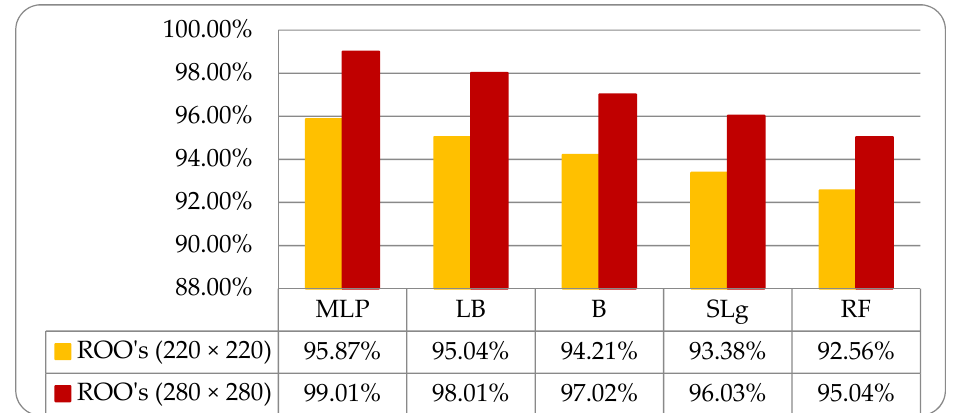
Figure 11. Comparative analysis for the classification of medicinal plant leaves using ML based classifiers where ROO’s Size (220 × 220) and (280 × 280).